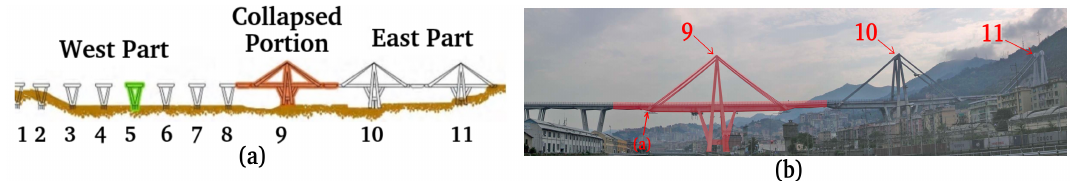
Figure 25. “Morandi” bridge: ( a ) Schematic representation, ( b ) Optical